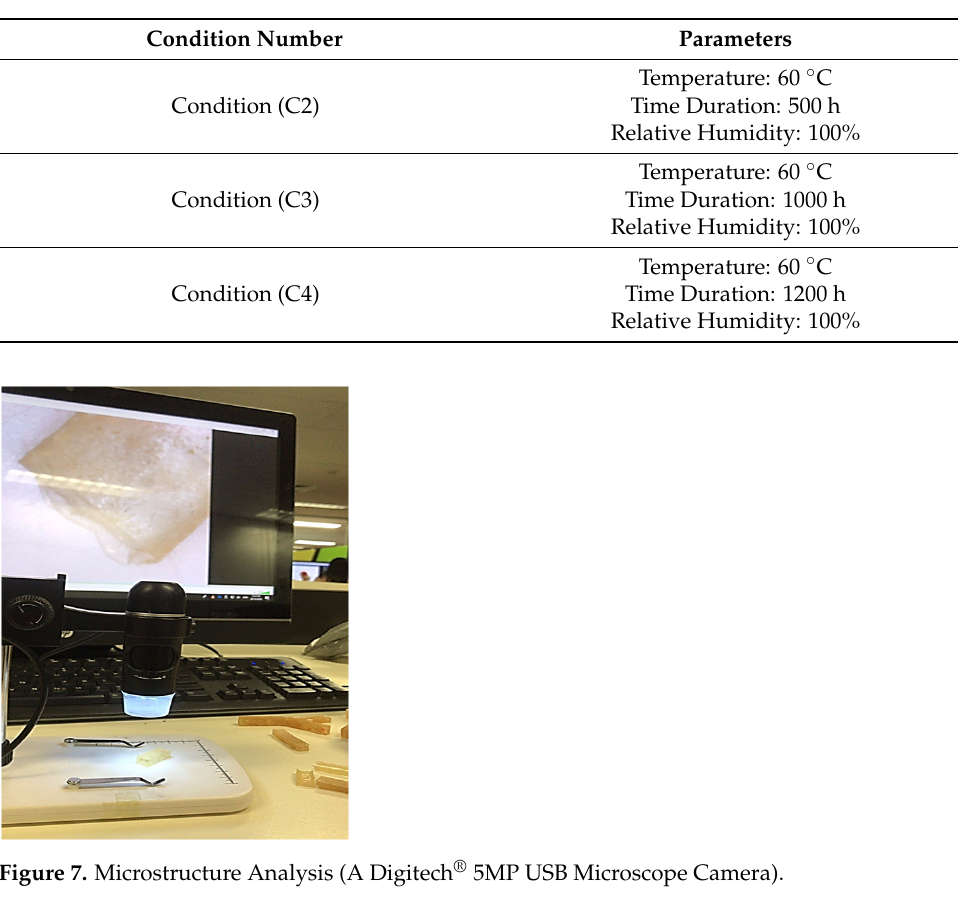
Figure 8. The schematic diagram of three-point flexure testing using a sample with dimensions 80 mm× 10 mm× 4 mm (L × W × H).